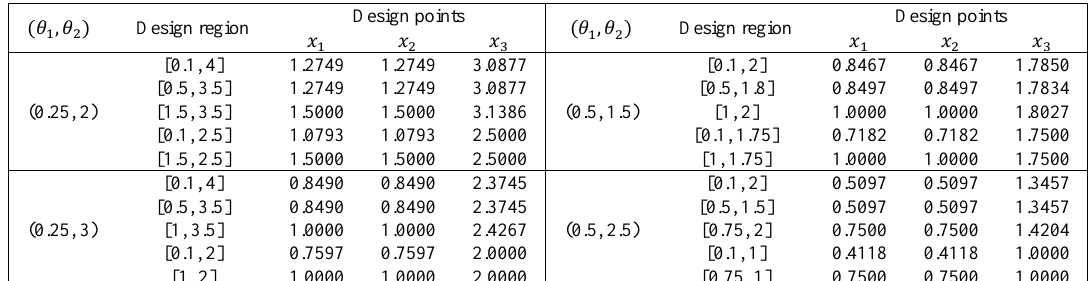
Table 2. D-optimal designs for generalized Pareto model with three support points having